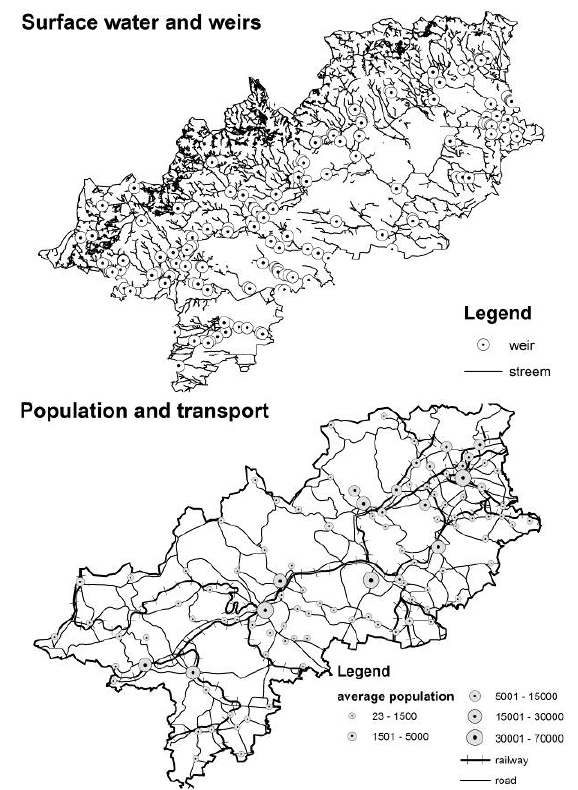
Figure 5. Selected classes from the land cover datasets in CORINE for land cover mapping in 2006 and 2012.